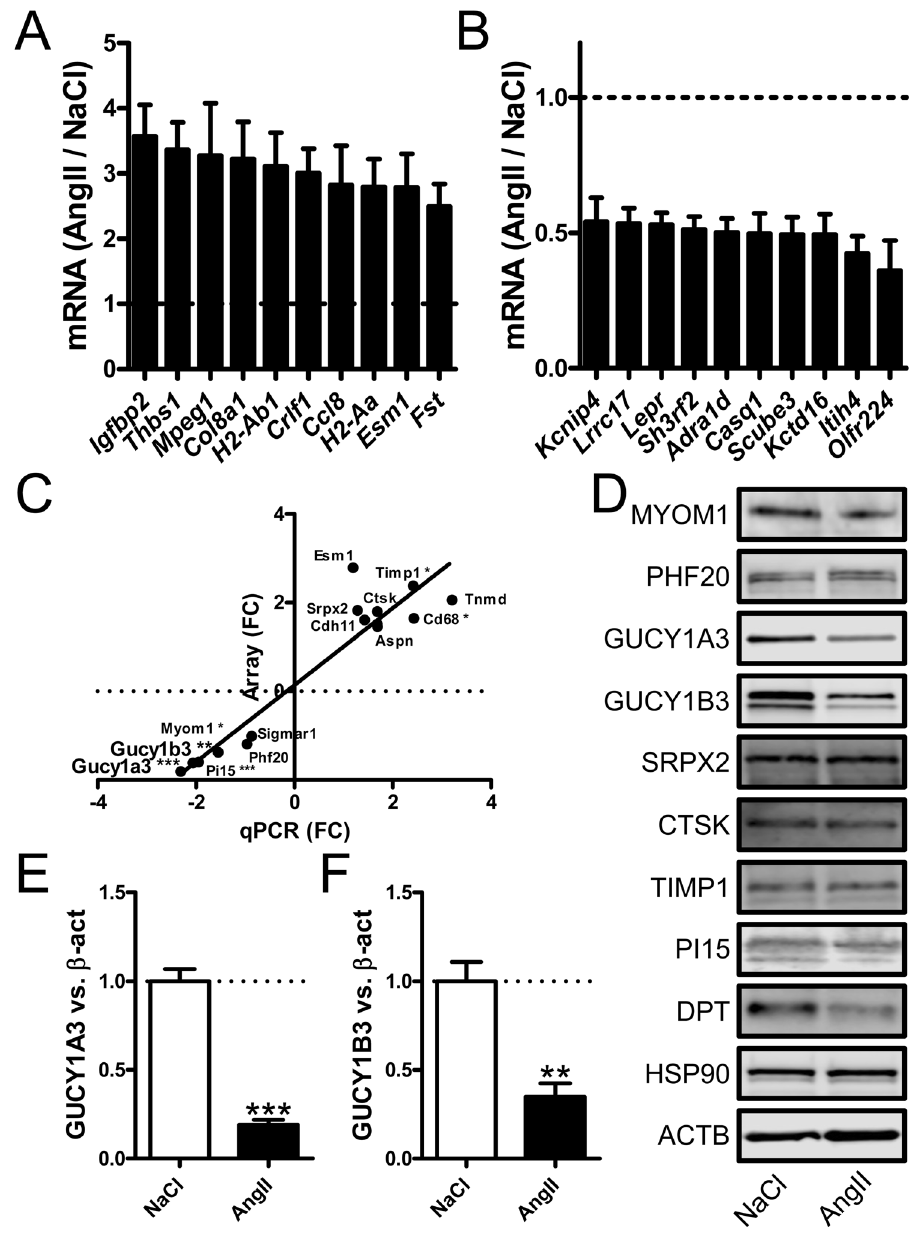
Figure 1. Differentially expressed mRNAs in the hypertensive aorta as determined by microarray analysis. To identify differentially expressed genes in the hypertensive arterial wall, we isolated the aorta from vehicle (physiological saline or NaCl, n = 7, mean arterial blood pressure (MAP): 103 ± 11 mmHg) and angiotensin II (AngII)-treated mice (n = 8, MAP: 186 ± 6 mmHg) and subjected the isolated RNA to microarray analysis. 235 genes were differentially expressed (SAM analysis, Q = 0). Panels A and B show the ten most upregulated and the ten most repressed mRNAs, respectively. All loading controls used herein for western blotting changed less than 10%, and non-significantly (Hsp90: q = 11; Gapdh: q = 51; Actb: q = 35), in the array experiment. 14 genes were chosen for confirmation by RT-qPCR in a material that included the original samples plus four samples in each group that were not included in the array experiment. Six of the mRNA changes, including those for Gucy1a3 and Gucy1b3 could be confirmed ( * P < 0.05, ** P < 0.01, P < 0.001). In panel C the fold change in the qRT-PCR experiment is plotted versus the fold change in the array experiment. A highly significant correlation (Spearman method, P < 0.0001) was seen. Western blotting was done in ( D ) using aortic protein lysates (n = 6/group) to assess changes for a selection of the genes in ( C) . To allow for detection of multiple targets, membranes were cut horizontally above and below the known molecular weights and hence full lane blots are not available. Panels E and F show summarized data at the protein level for the subunits (GUCY1A3, GUCY1B3) of the soluble guanylyl cyclase